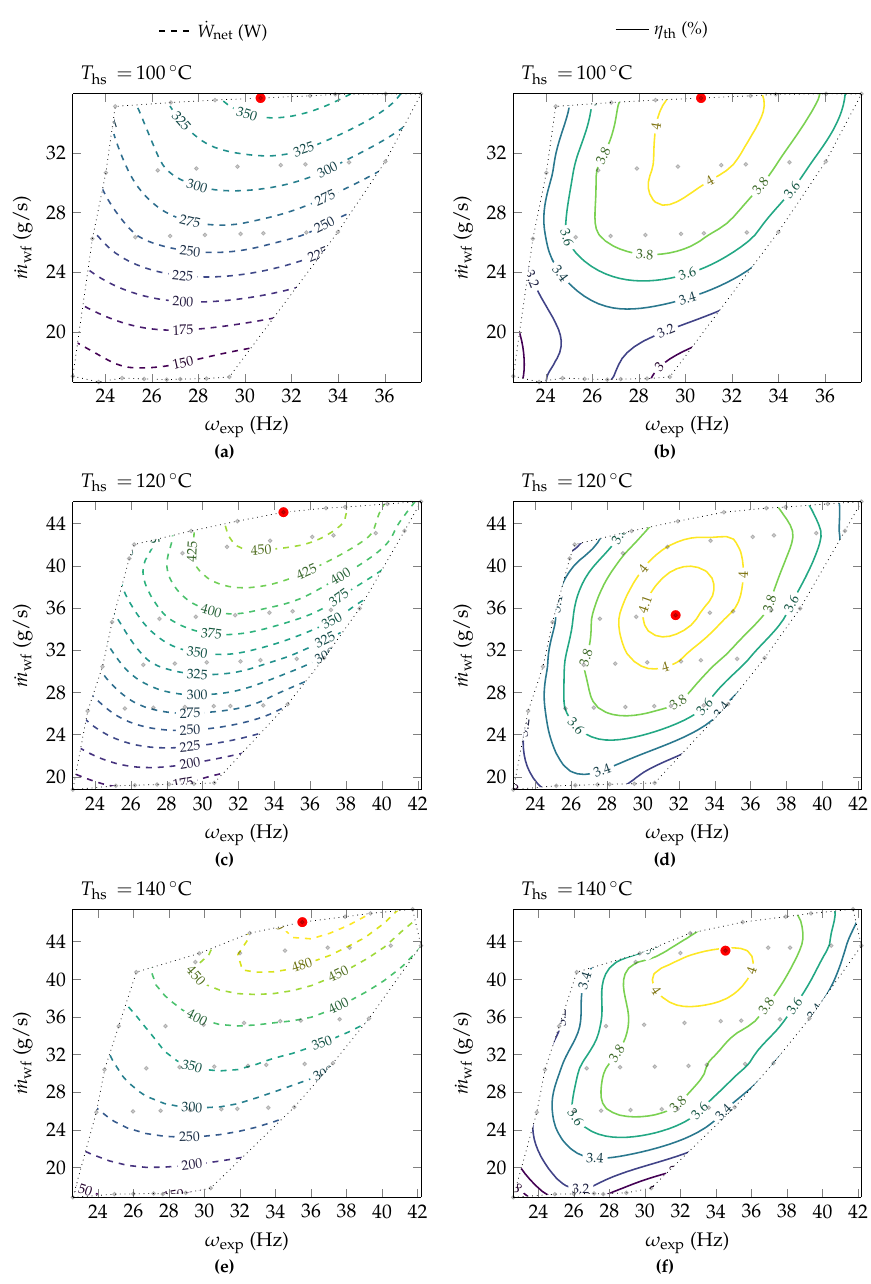
Figure 4. ORC part-load performance maps: contour plots of the net power output, ˙ W net ( (a) , (c) , (e) ), and of the thermal efficiency, η th ( (b) , (d) , (f) ), as functions of the expander spindle speed, ω exp , and of the working fluid mass flowrate, ˙ m wf , for heat-source temperatures of 100 ( (a) and (b) ), 120 ( (c) and (d) ) and 140 ◦ C ( (e) and (f) ). Performance map obtained from cubic-spline interpolation of experimental data (indicated as grey dots). The optimum values highlighted in red are further described in Table 2.